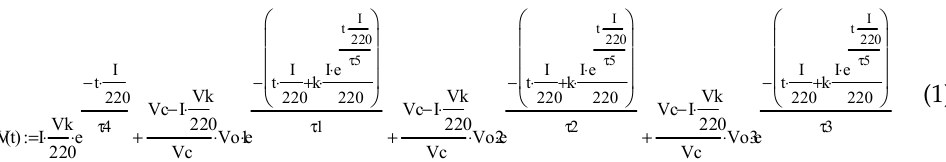
Figure 5. Curve of L brand 18650, Epoch = 100, look_back = 10.